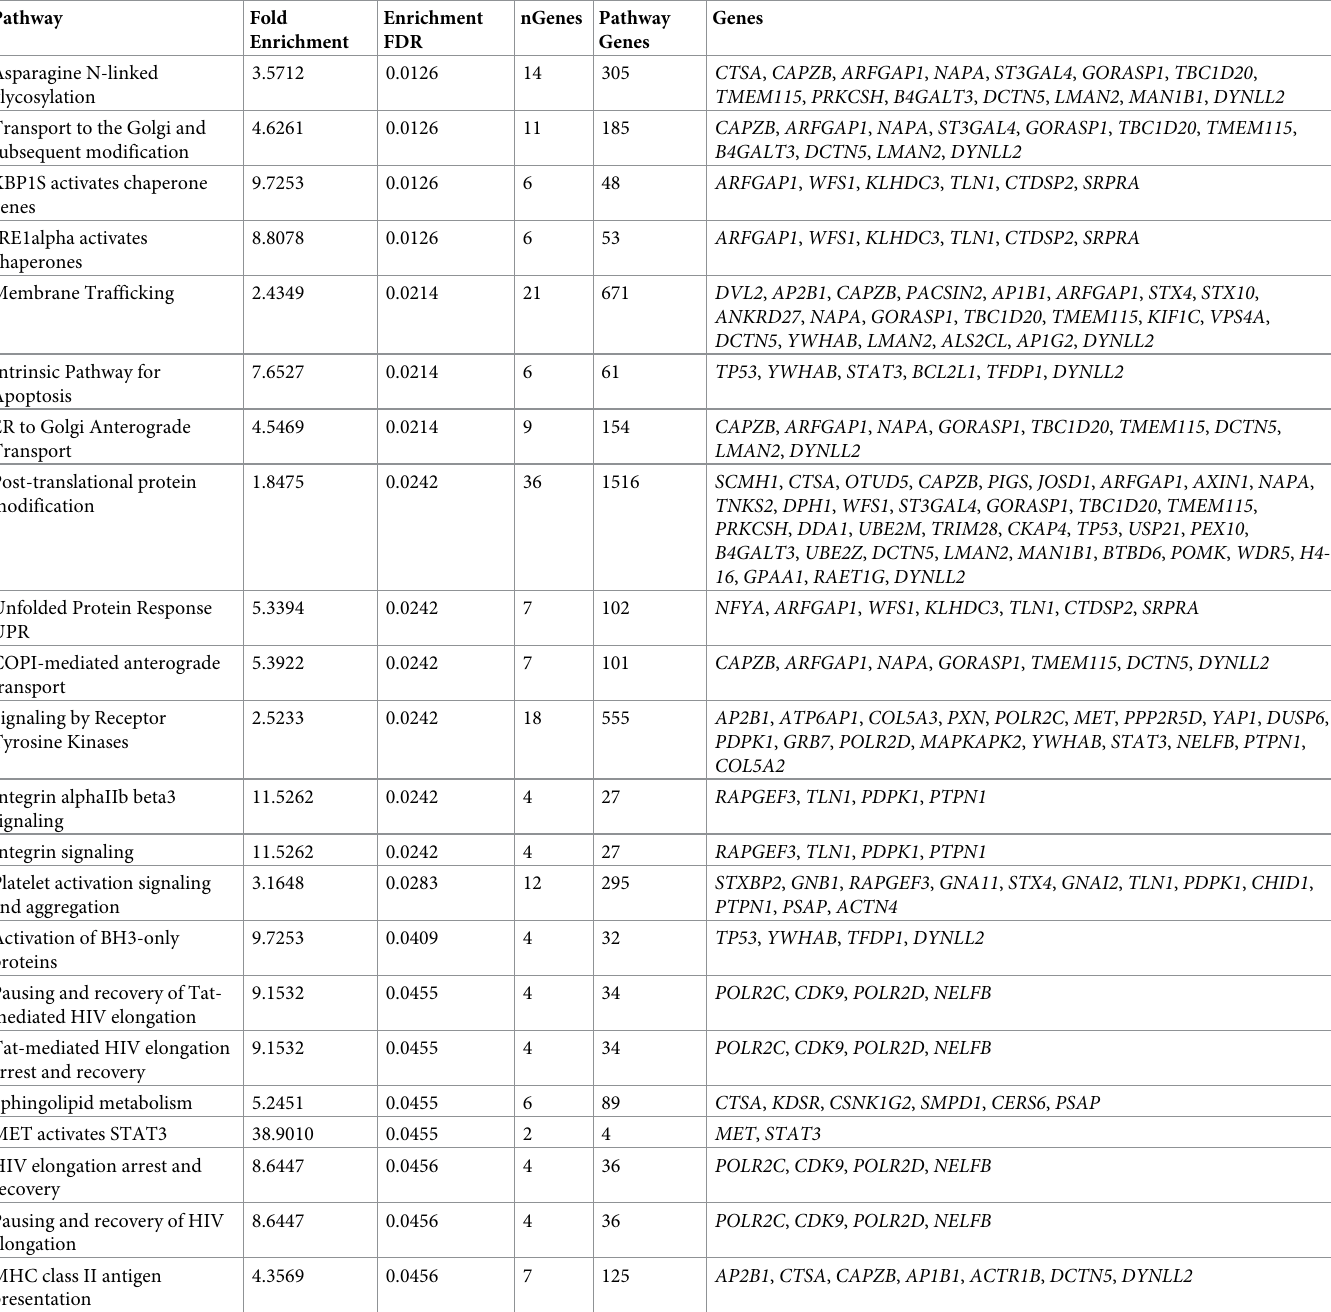
Table 6. The results of the pathway enrichment analysis. The results of the pathway enrichment analysis for genes whose expression in the cone region of corneal epi- thelium was found to be correlated with the eye rubbing manner. Pathway Fold Enrichment nGenes Pathway Genes Enrichment FDR Genes Asparagine N-linked